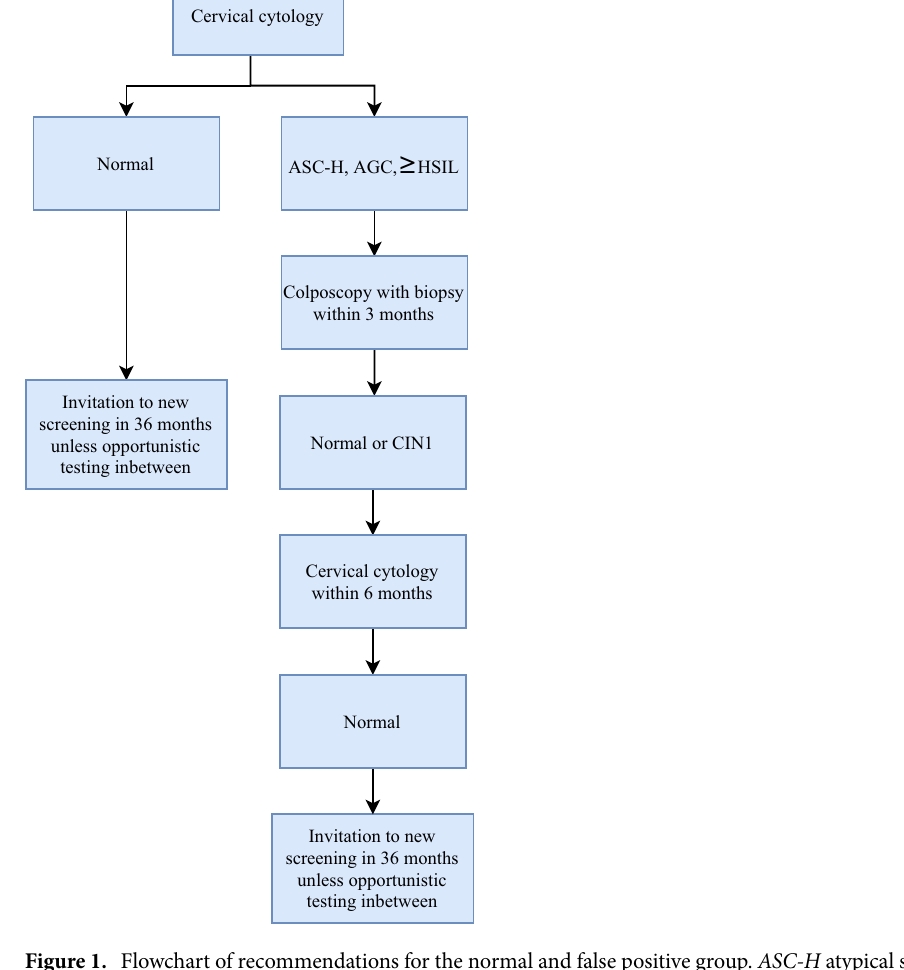
Danish target population for cervical cancer screening 11 . Women are invited to book a screening appointment with their general practitioner (GP) when the age-specific interval has passed since their latest invitation or cervi- cal cytology sample (whichever came last) 12 . In case of non-participation, reminders are sent at 3 and 6 months after the initial invitation. The primary screening method for 23–59-year-old women are microscopic exami- nation of the cytology sample, while 60–64-year-old women are offered a human papillomavirus (HPV) DNA check-out test 12 . Cytology are categorized per the Bethesda 2001 classification as: normal, inadequate, Atypical Squamous Cells of Undetermined Significance (ASC-US), Low-grade Squamous Intraepithelial Lesion (LSIL), Atypical Squamous Cells cannot exclude HSIL (ASC-H), High-grade Squamous Intraepithelial Lesion (HSIL), Squamous Cell Carcinoma (SCC), Atypical Glandular Cells (AGC), Adenocarcinoma In Situ (AIS), Adenocar- cinoma (ACC), and malignant tumor cells 13 . Outside the organized screening program, GPs or gynecologists can obtain opportunistic cervical samples, also in women below 23 years. The screening program as well as any opportunistic testing, surveillance or treatment is free of charge 14 . If a cervical cytology sample is inadequate or abnormal (≥ ASC-US), the woman is enrolled in a surveillance program. For women with low-grade cytological abnormalities (ASC-US and LSIL), this includes either triage with HPV reflex testing or repeat cytology testing 12 . Women with high-grade cytological abnormalities (ASC-H, AGC, HSIL+) are referred directly to colposcopy for cervical biopsy (a surveillance biopsy) within 3 months 15 (Fig. 1). Cervical biopsies are graded using the Cervical Intraepithelial Neoplasia (CIN) classification as: normal (including inflammation and non-specific reactive features), CIN grade 1, 2 or 3/AIS, or invasive cancer 16 . If the surveillance biopsy is normal or shows CIN1, the woman is recommended a second cervical cytology sample